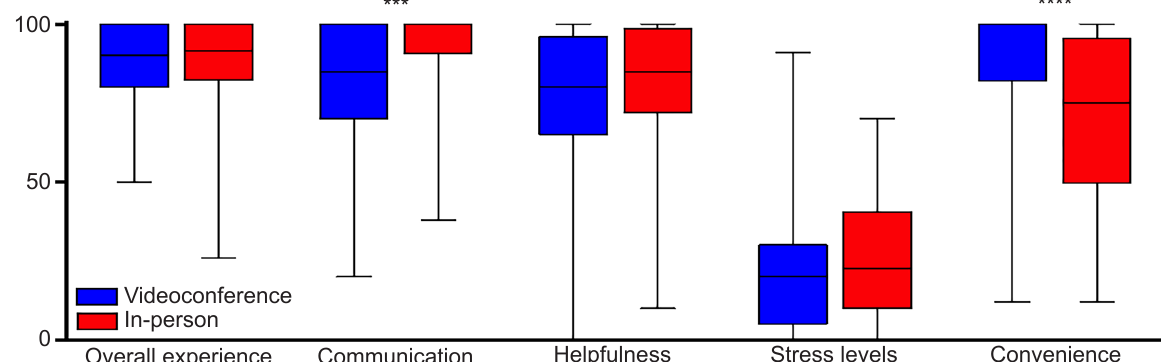
Figure. Box and whiskers plot comparing participant ratings. Statistical analysis conducted using t-test or Mann-Whitney U as appropriate. Displayed is median, interquartile range and minimum to